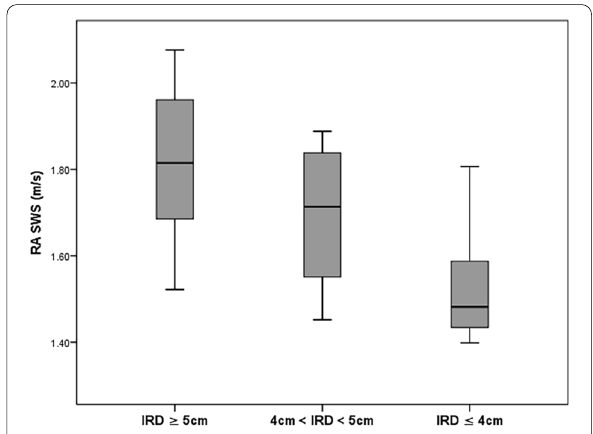
Fig. 6 Boxplot of RA shear wave speed distribution in 36 DRA patients ( IRD inter-rectus distance, RA rectus abdominis, SWS shear wave speed)